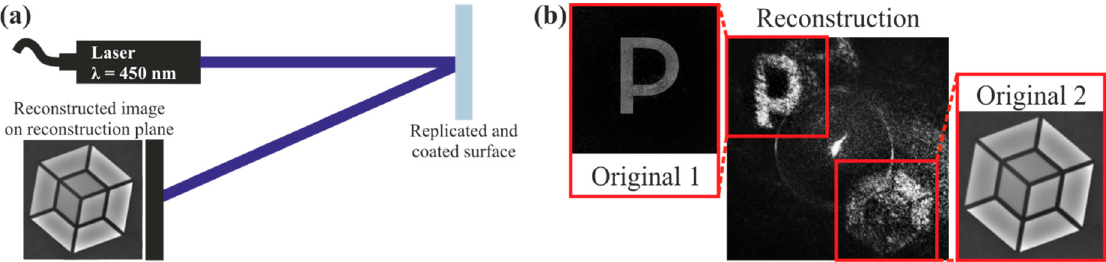
Figure 6. ( a ) Setup for the optical testing and ( b ) reconstruction of coated replicated surface.